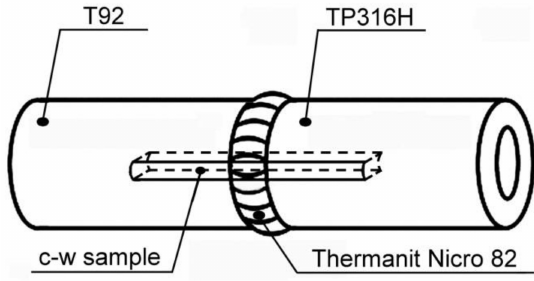
Figure 2. Schematic cross-weld (c-w)